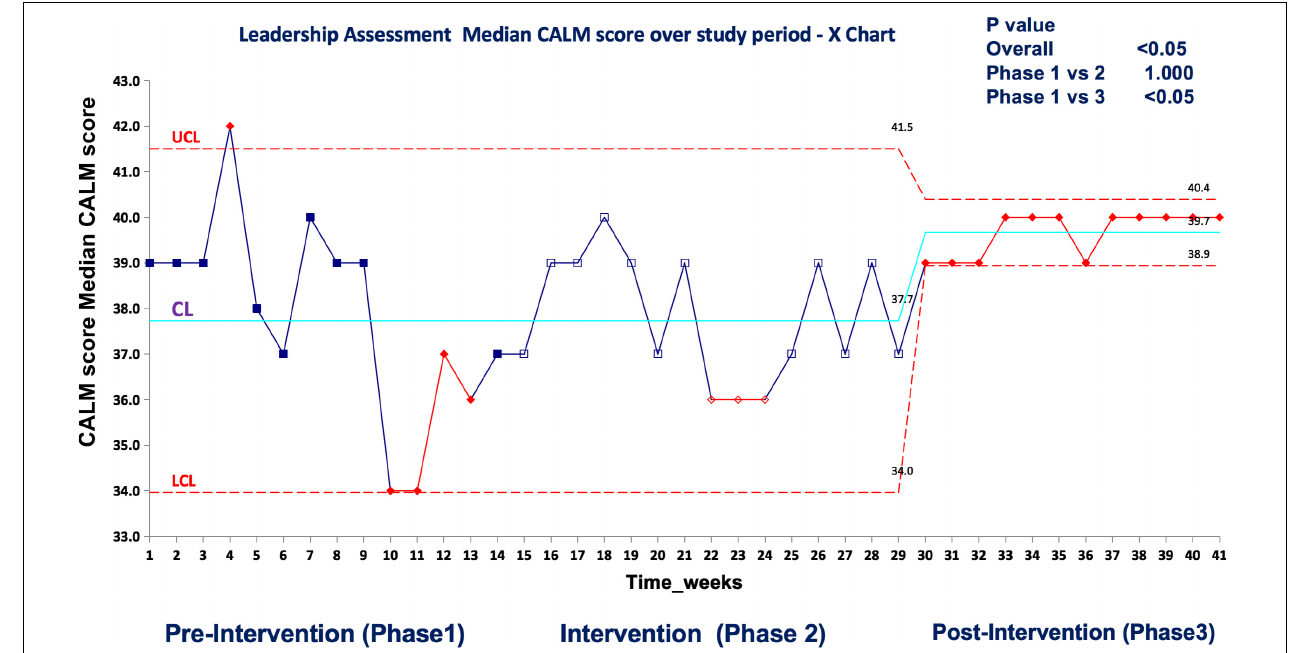
FIGURE 10 | Median CALM score (leadership assessment) during the first-hour management of shock in real patient events in the emergency room UCL, upper control limit; CL, center line; LCL, lower control limit.